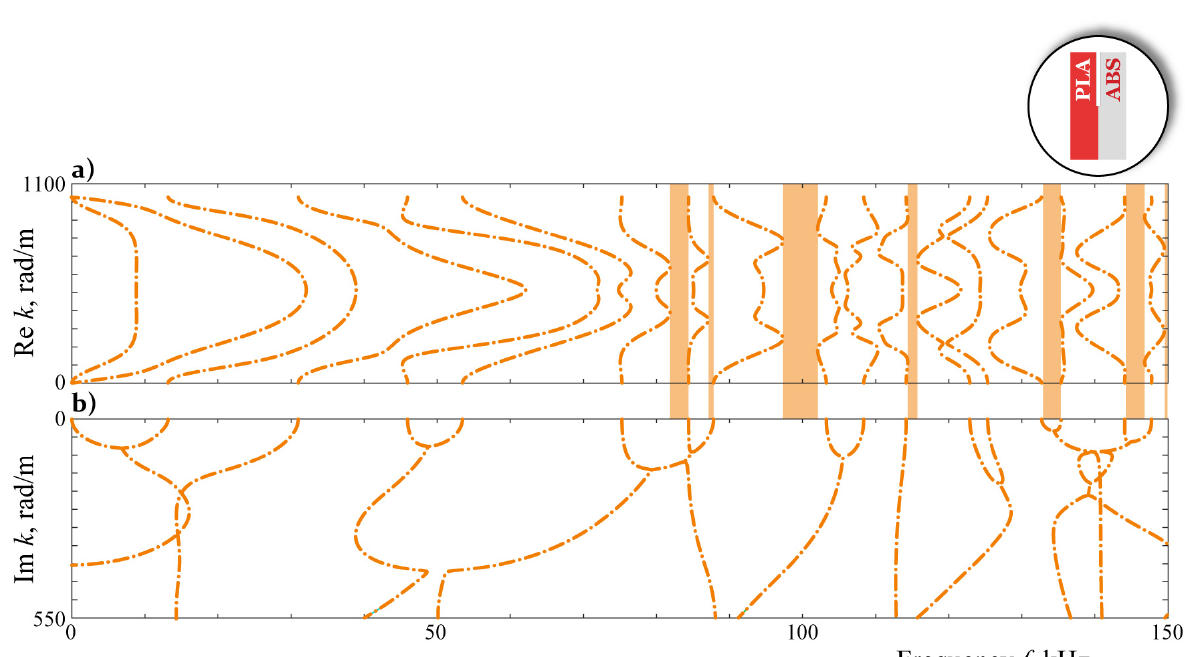
Figure 6. The real ( a ) and imaginary ( b ) parts of the wavenumbers of propagating GWs propagating in AMM with edge